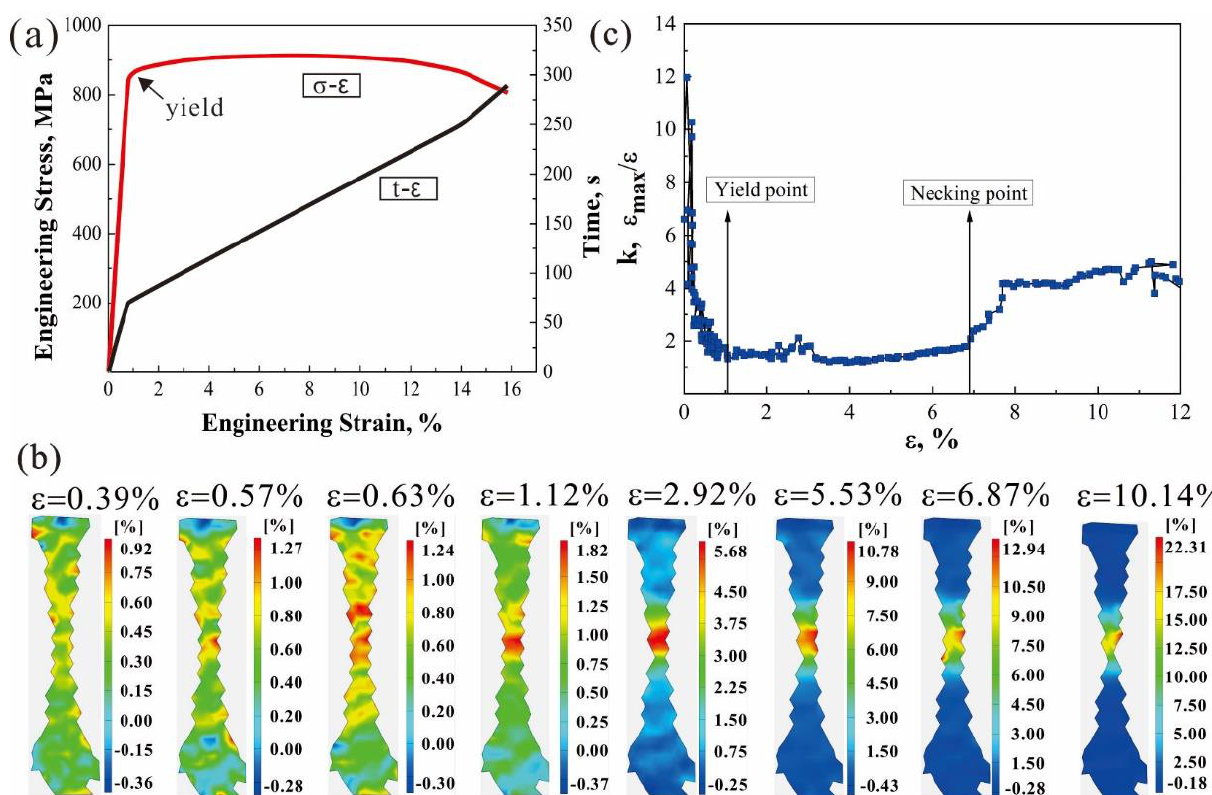
Figure 4. Tensile property of the TC4 alloy: ( a ) engineering stress – strain curve, ( b ) the full-field strain nephograms of the gauge section at different tensile strains, and ( c ) the strain concentration factor-strain curve.